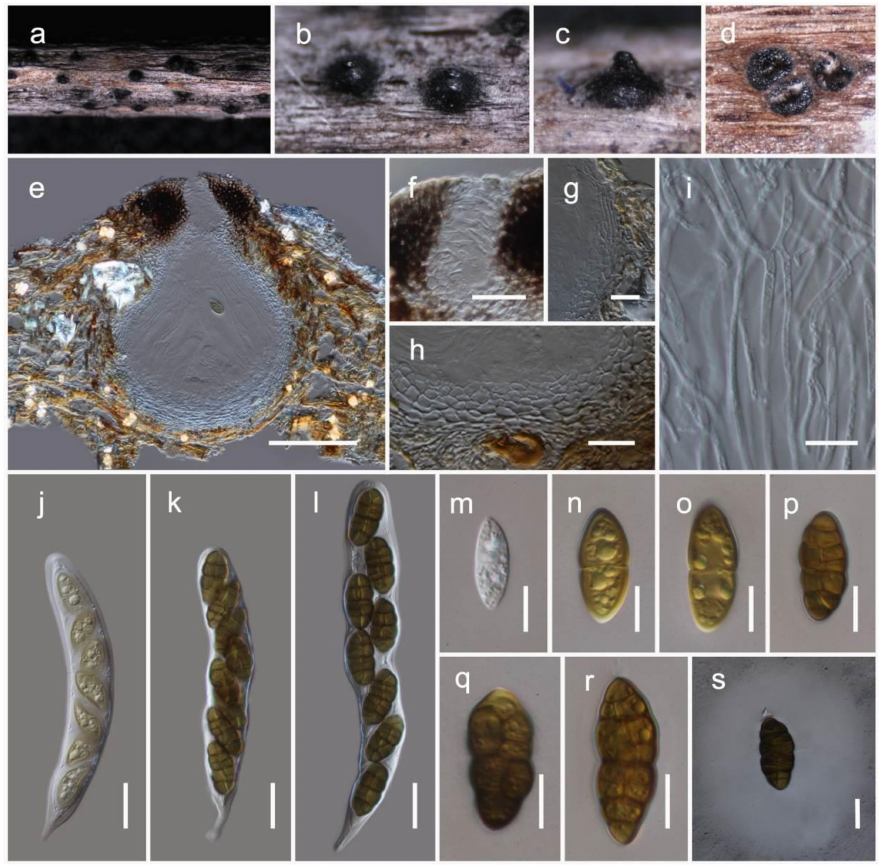
Figure 7. Sexual morph of Lophiomurispora hongheensis (HKAS110127, holotype). ( a – c ) Ascomata on the dead woody twigs of Dodonaea viscosa ; ( d ) cross section of ascomata; ( e ) vertical section of ascoma; ( f ) closeup of ostiole; ( g,h ) peridium; ( i ) pseudoparaphyses; ( j – l ) asci; ( m – s ) ascospores ( s in Indian Ink); Scale bars, ( e ) 100 µ m; ( f – h,j – l ) 20 µ m; ( i , m – s ) 10 µ